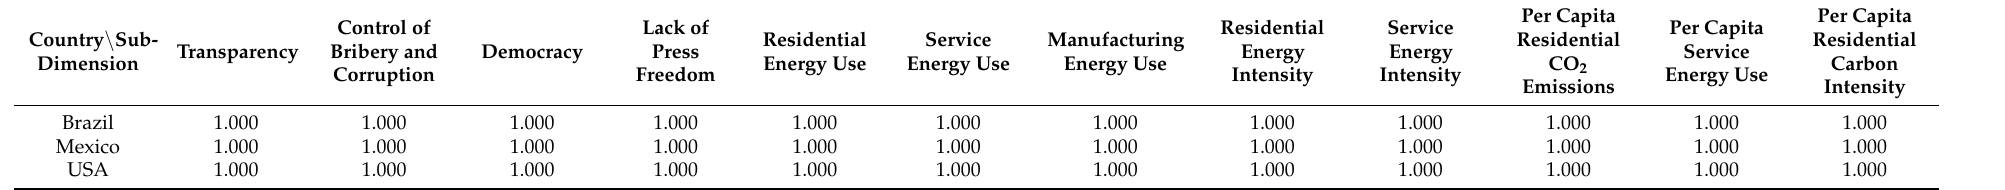
Table 7. Sub-dimensional energy resilience scores of economies in the Asia-Pacific. Control of Bribery and Corruption